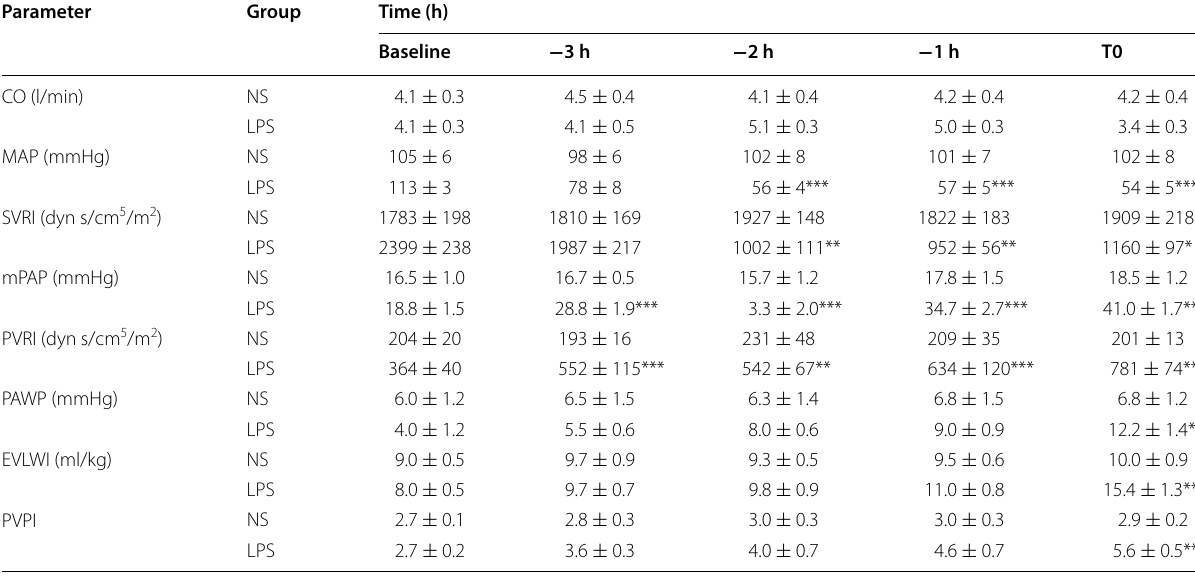
Hemodynamic parameters are compared between the saline control and LPS-challenged group. (Data are mean *** P < 0.001; versus control group) CO cardiac output, MAP mean arterial pressure, SVRI systemic vascular resistance index, MPAP mean pulmonary arterial pressure, PVRI pulmonary vascular resistance index, PAWP pulmonary artery wedge pressure, EVLWI extravascular lung water index, PVPI pulmonary vascular permeability